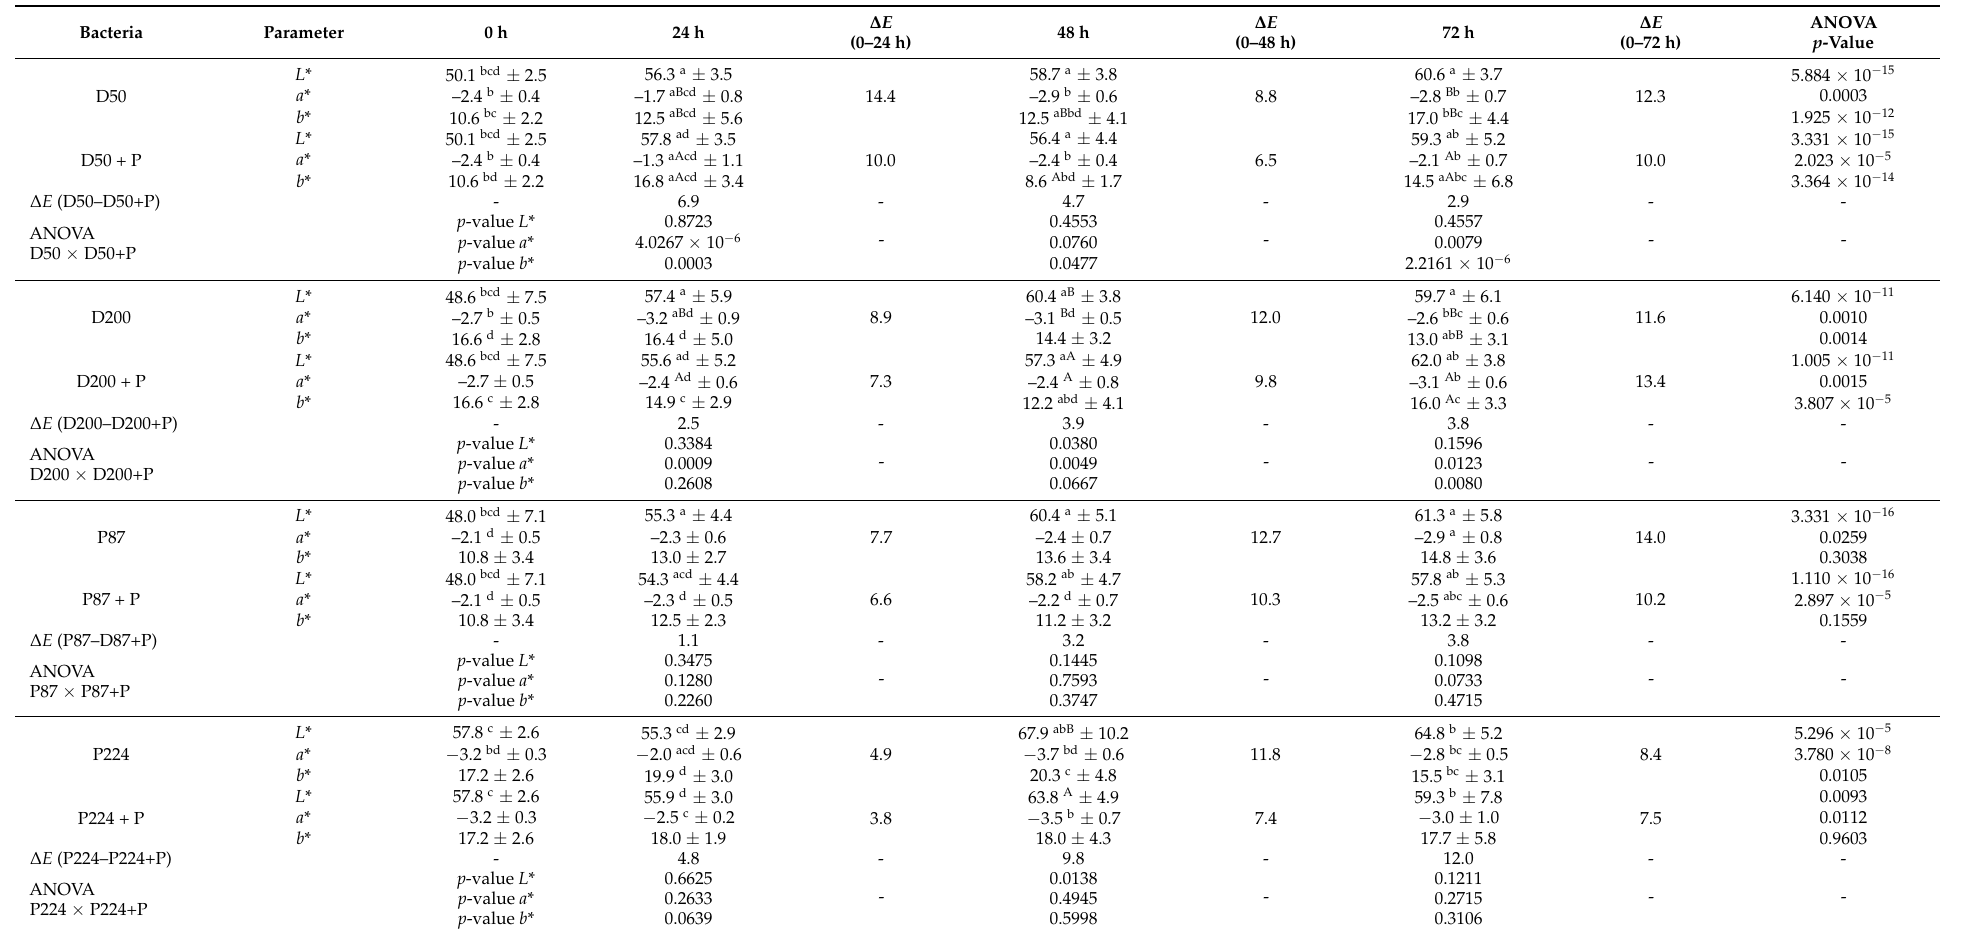
Table 1. Potato cylindrical cut color (Mean ± SD) during storage at 25 ◦ C and values of the color change coefficient ∆ E